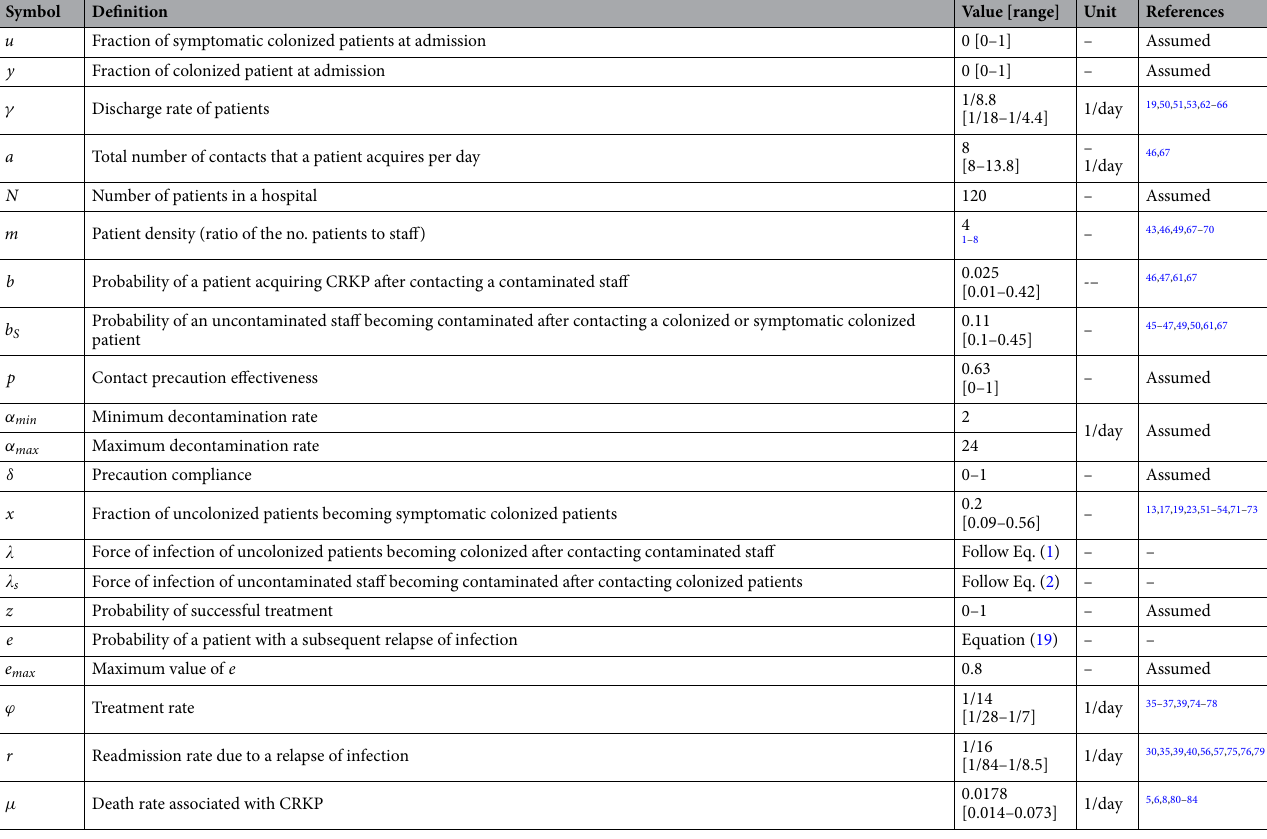
Table 1. Variables and parameters of the